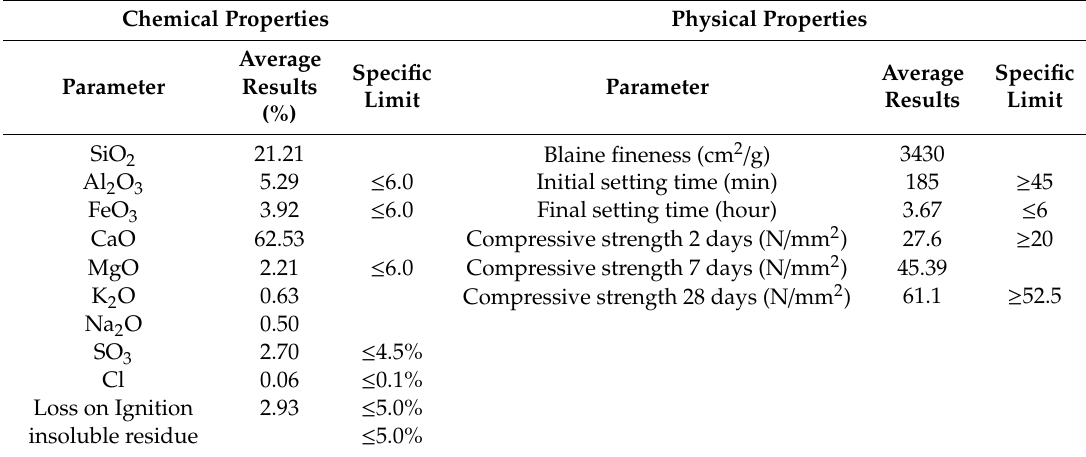
Table 3. The Cement chemical and physical properties. BS EN 196, parts 1, 2, 3, and 6 were used as cement test method